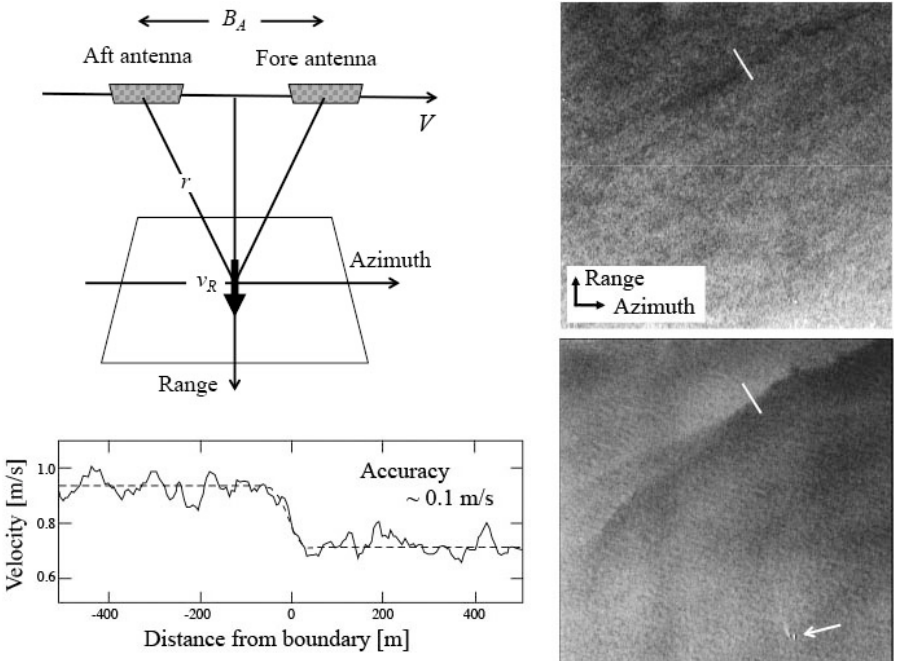
Figure 22. From top left in clockwise direction: Geometry of ATI SAR, intensity image (8 km square) of the Gulf Stream boundary off Virginia Beach, USA, produced by the JPL–AIRSAR, InSAR phase image, and estimated current velocity. The survey vessel (arrowed) is used as a reference to compute the absolute interferometric phase and the current velocity [145,146].